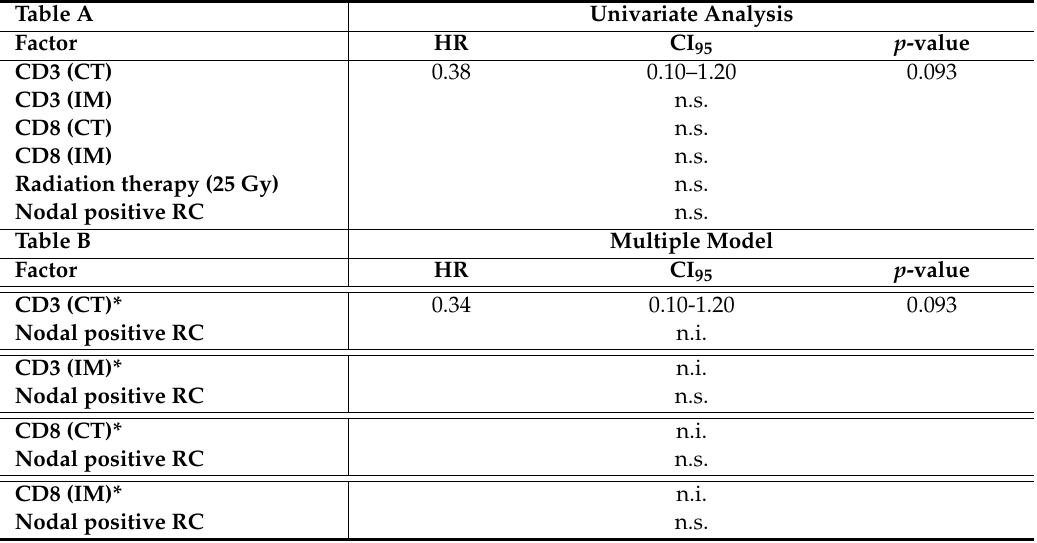
Note. Table A – univariate analysis; Table B – multiple model: double lines indicate separate models; CT: central tumor, IM: invasive margin; HR: hazard ratio, CI: confidence interval; radiation therapy according to